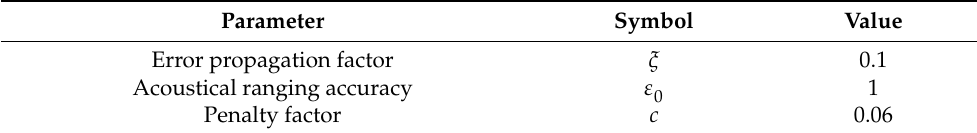
Table 2. The R function for the TD method.